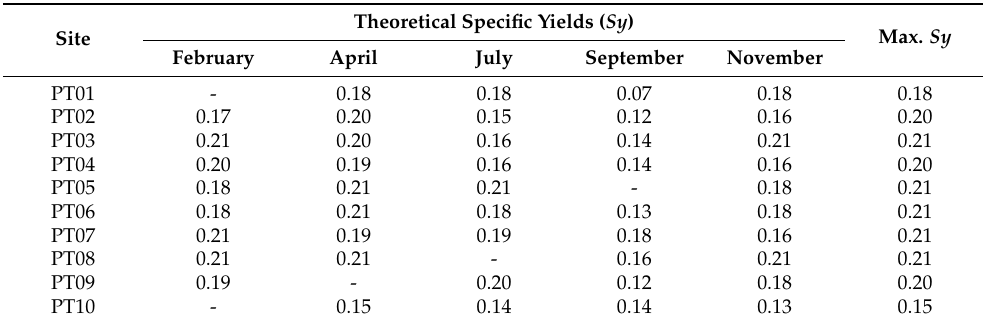
Table 5. The estimated theoretical specific yields ( Sy ) were calculated from Van Genuchten for five different months of 2019.